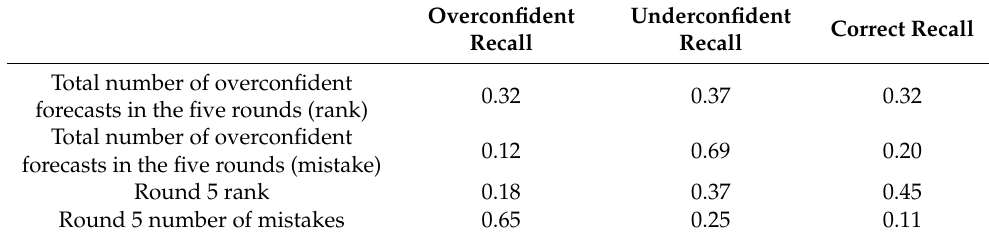
Table 3. Recall Patterns.